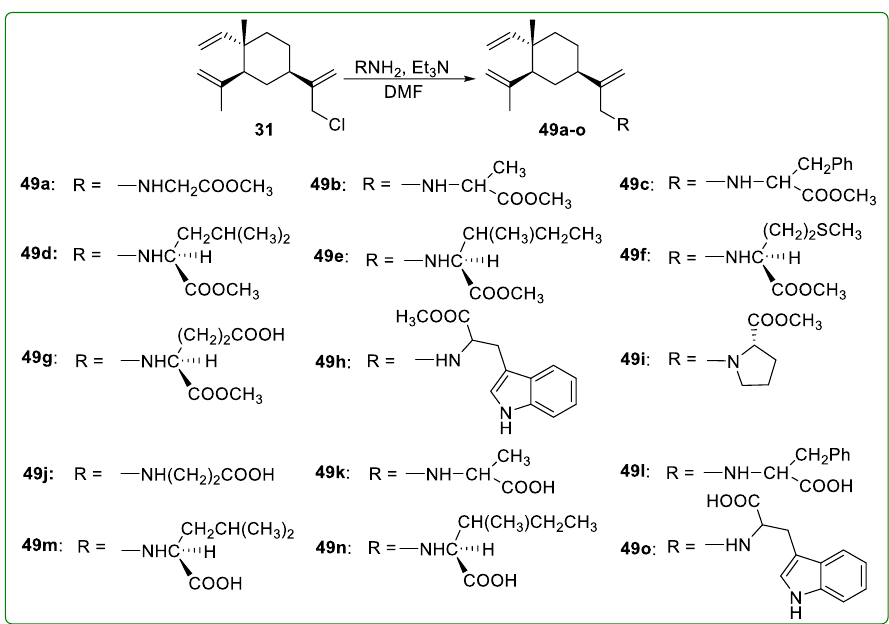
Figure 17. Chemical structures of β -elemene amino acid derivatives 49a – o .